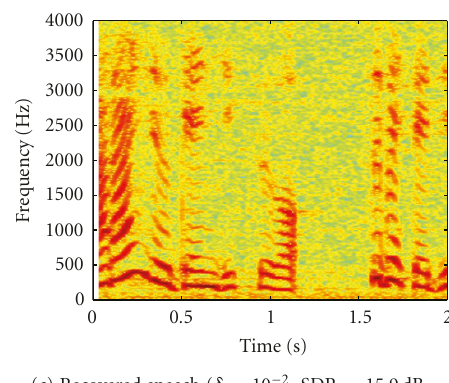
Figure 16: Spectrograms of speech